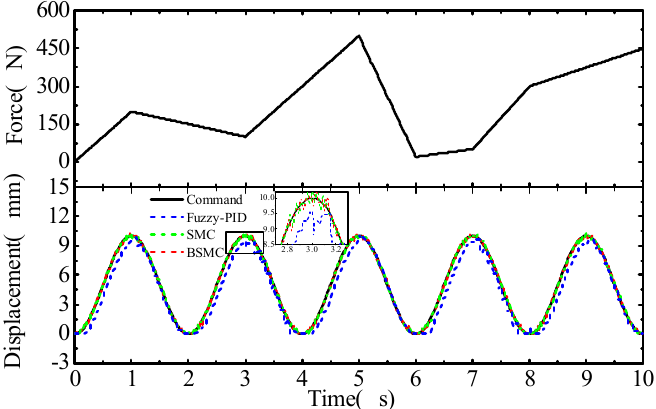
Figure 8. Sine response of the cylinder under random ramp load.